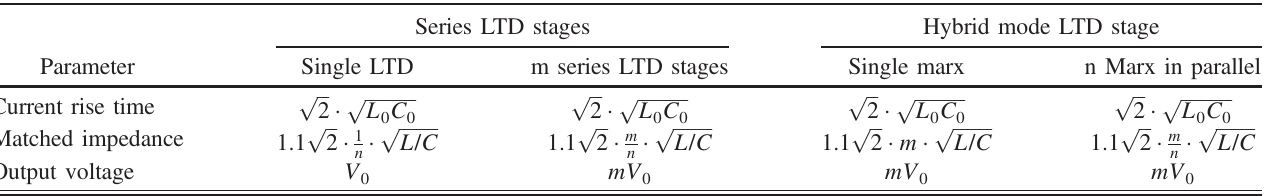
TABLE I. Parameter comparisons of the hybrid mode LTD stage and series LTD stages.